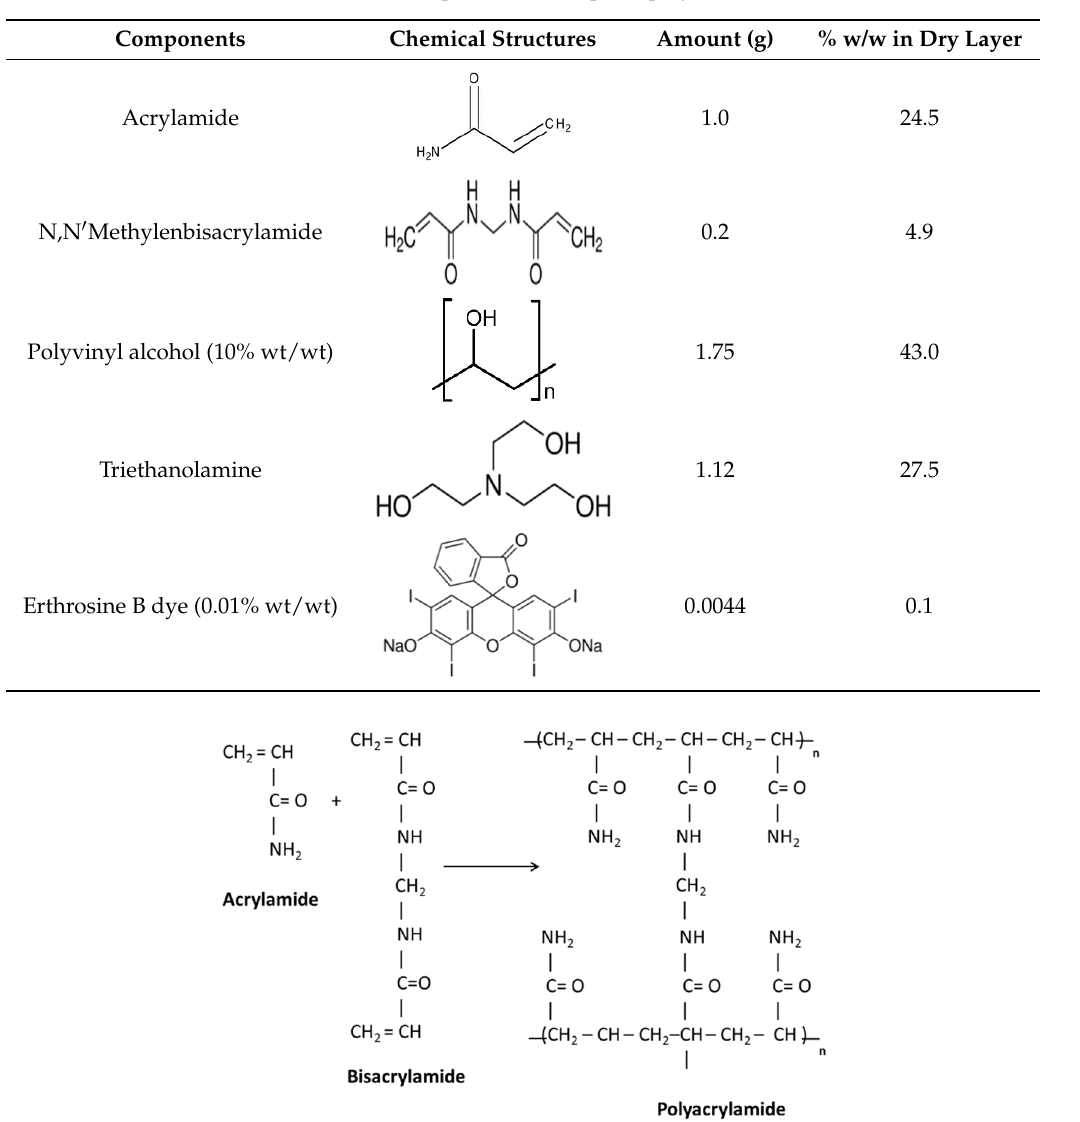
Table 1. Composition of the photopolymer.